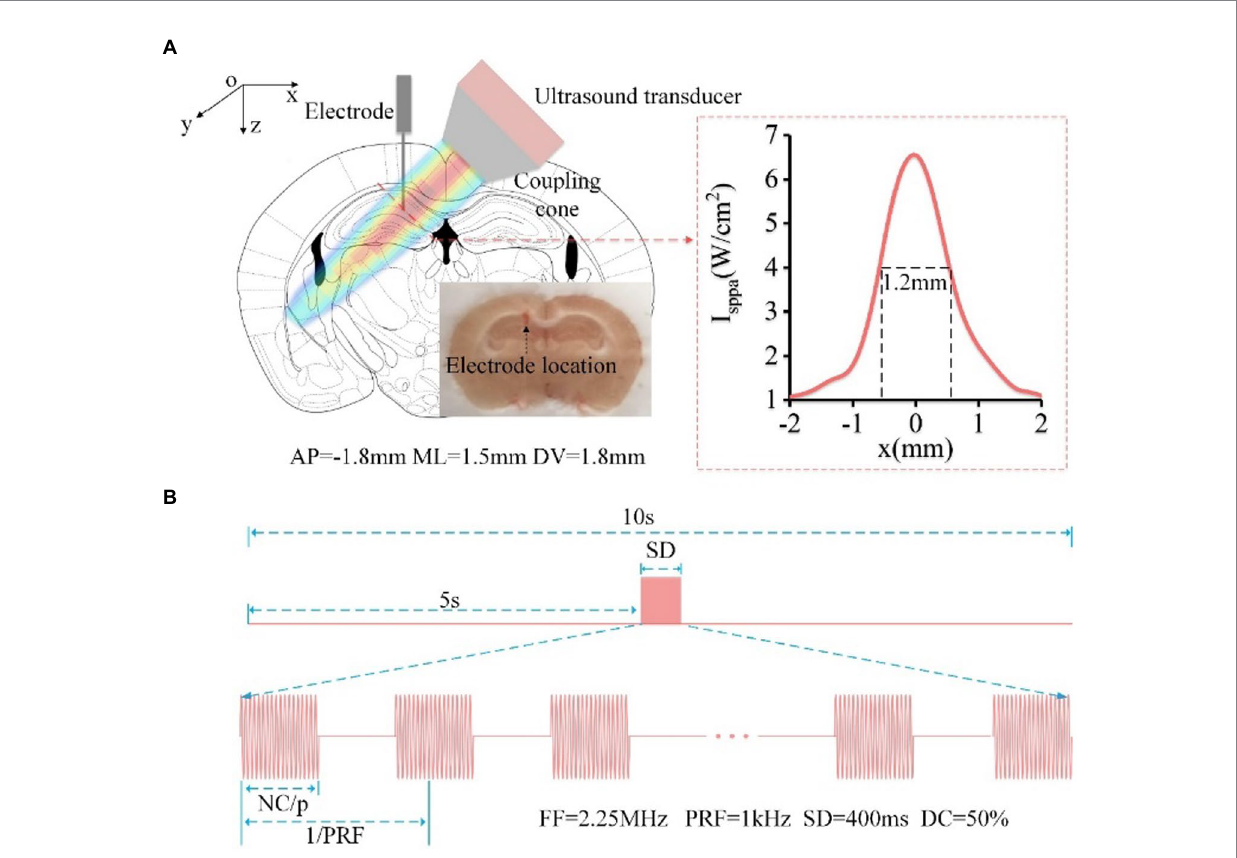
FIGURE 1 (A) Schematic diagram of mouse head stimulated by focused ultrasound, including the location of the ultrasound spot and electrode implantation (AP: − 1.5 mm, ML: 1 mm, DV: − 1.5 mm, relative to the bregma). The red dotted line in the right box is the reconstruction profile of the ultrasound field, and the FW50%M is approximately 1.2 mm. The electrode location was in CA1 area. (B) Timing diagram of ultrasound stimulation, FF = 2.25 MHz, PRF = 1 kHz, SD = 400 ms, DC =